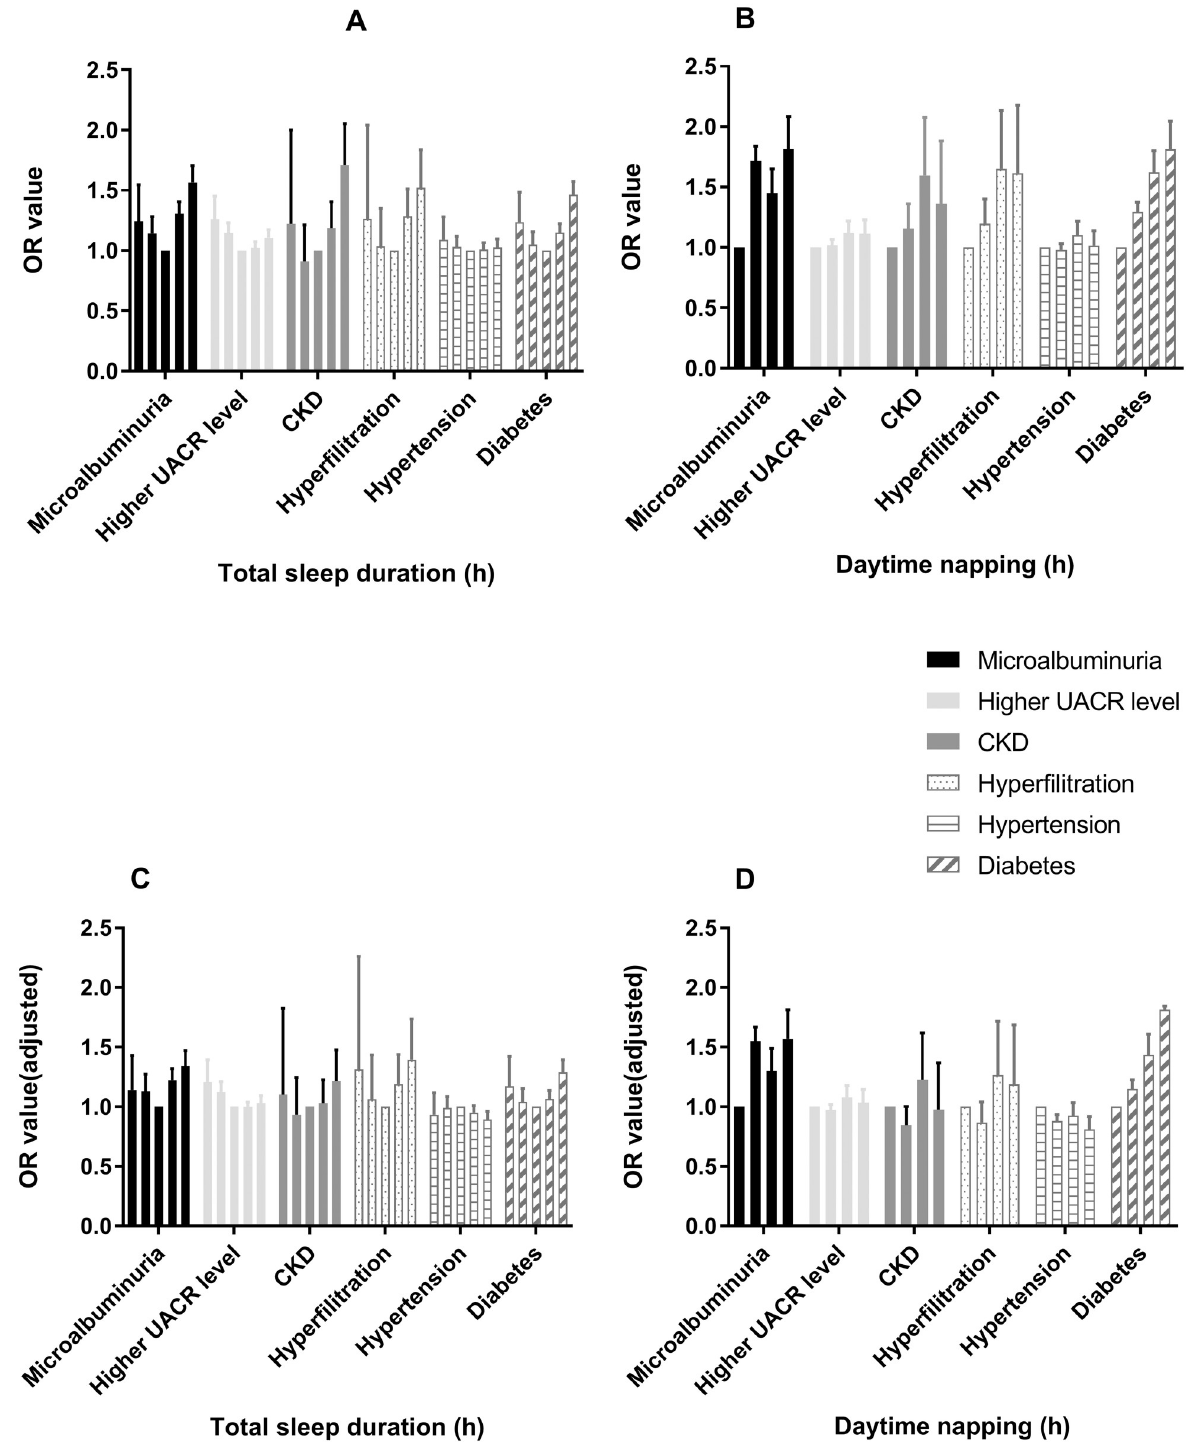
Fig 1. The association between sleep duration and risks for multiple health outcomes. (A and C) The U-shaped association between total sleep duration and risks for multiple health outcomes. (B and D) The positive association between daytime napping duration and risks for multiple health outcomes. The bars in each group of data in the figure represent the total sleep duration of < 6, 6–7, 7–8, 8–9 and > 9 hours or represent the daytime napping duration of 0, 0–1, 1–1.5 and > 1.5 hours, successively. Figs 1C and 1D were adjusted for age, sex, BMI, HC, WC, alcohol consumption and smoking habits, physical exercise, TG, TC, HDL, LDL, GGT, blood glucose (except for diabetes), and blood pressure (except for hypertension).